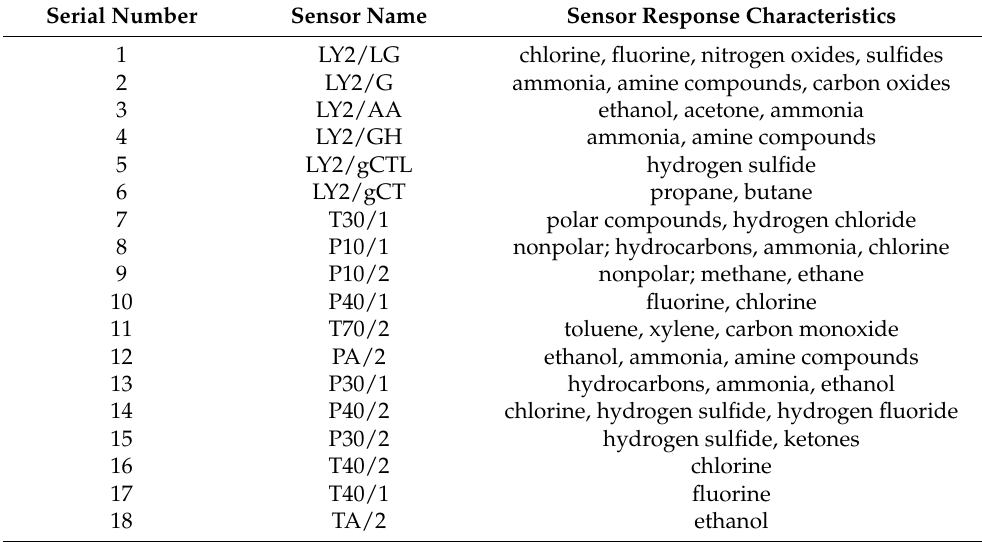
Table 1. Response characteristics of E-Nose